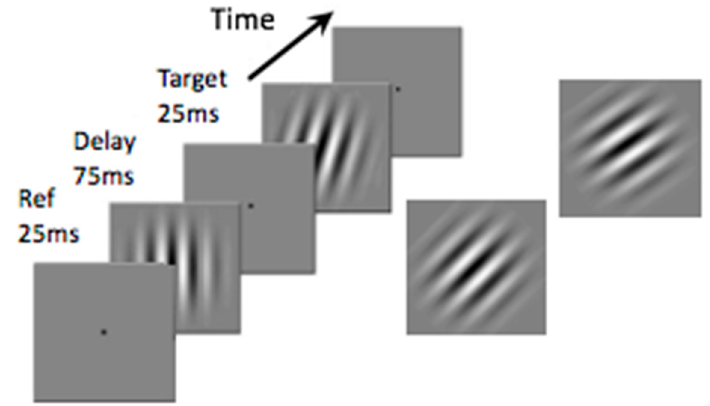
Figure 3. An example of the displays used to assess the oblique effect using gratings. In one condition the reference grating (“Ref”) is vertical and the test grating is oriented slightly clockwise or counter-clockwise to vertical. Thresholds for reliable discrimination can be determined. In a second condition, the reference is oriented at 45 degrees from vertical and orientation thresholds are again determined. Adapted from Tibber et al. [24].